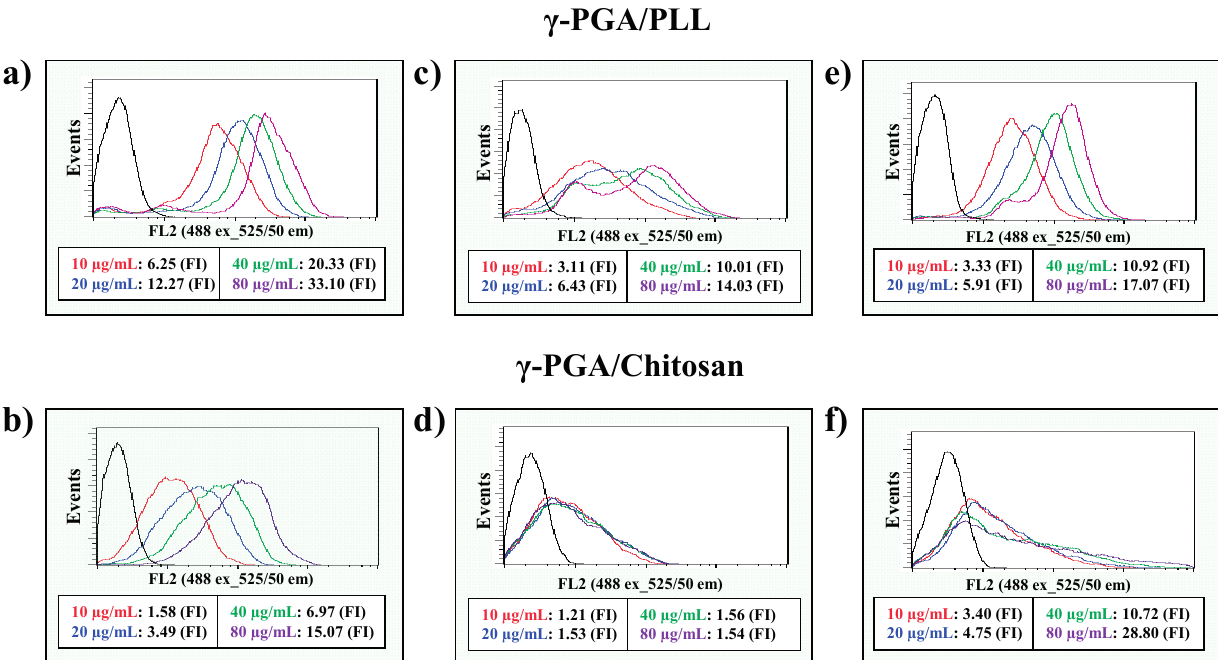
Figure 6. The cell viability of γ -PGA/PLL (up) and γ -PGA/Chitosan (down), determined by the MTS assay (( a , b ) HeLa cells, ( c , d ) RAW264.7 cells, ( e , f ) DC2.4 cells). The two types of nanocomposites were incubated with the displayed concentrations (from 0.3125 µg/mL to 80 µg/mL) for 24 h. All experiments were performed in triplicate.